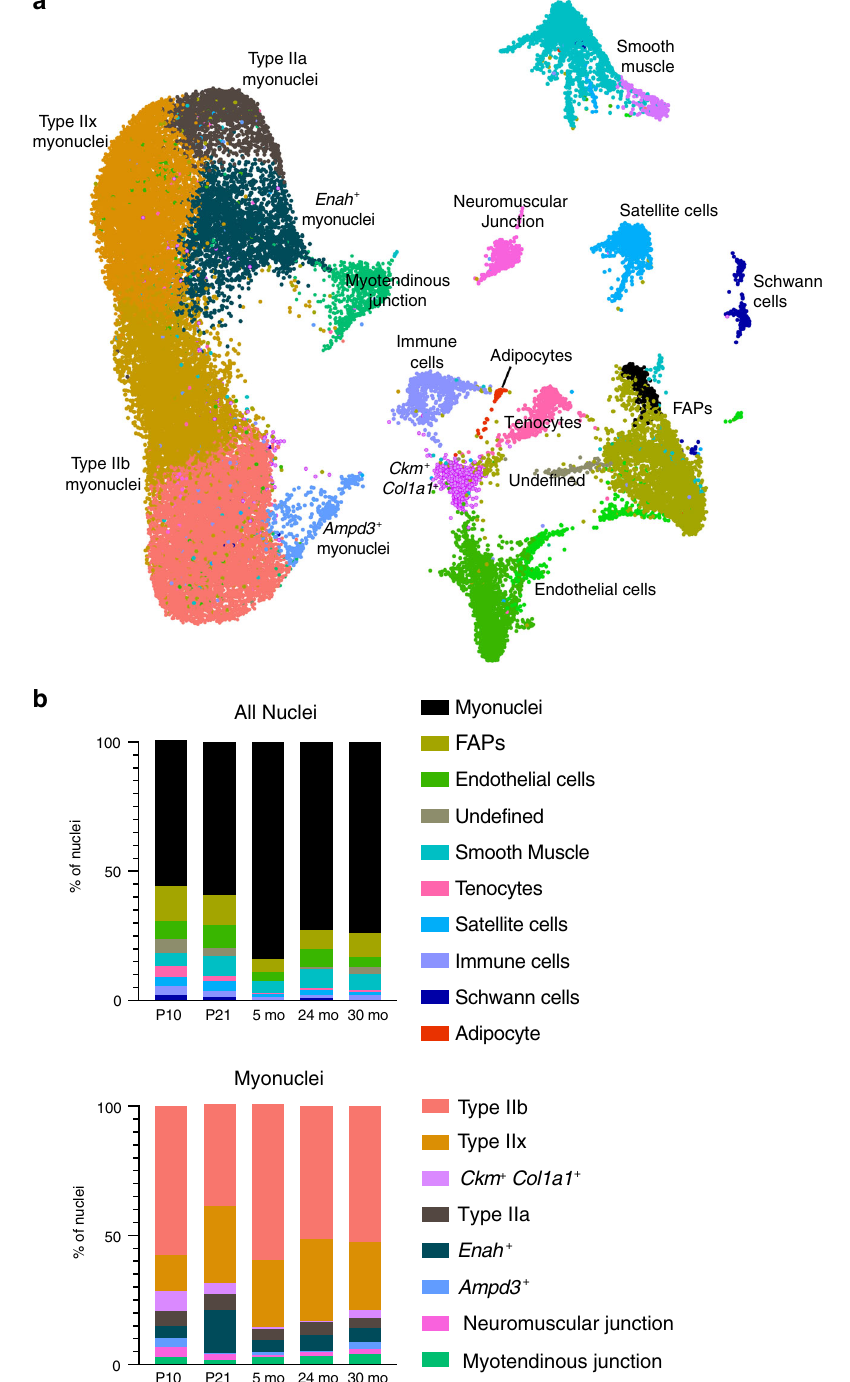
Fig. 5 Integration of snRNA-seq across the lifespan reveals myonuclear population dynamics. a Integrated UMAP of snRNA-seq data from postnatal day (P) 10, P21, 5-month, 24-month, and 30-month tibialis anterior muscle. b Proportional composition of nuclear types across the lifespan. Major categories (FAPs, endothelial cells, smooth muscle) include closely-related subpopulations. Myonuclei are combined (top graph) and subsetted (bottom graph) to display myonuclear composition